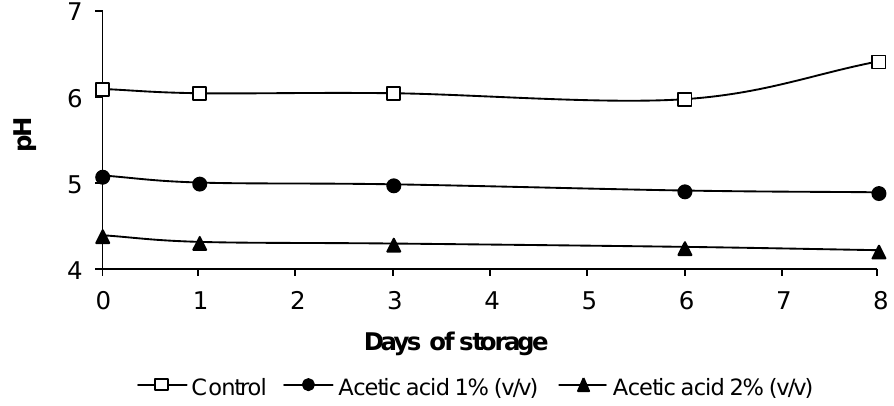
Figure 1. The evolution of pH in chicken legs treated with acetic acid. The data are the mean values of six